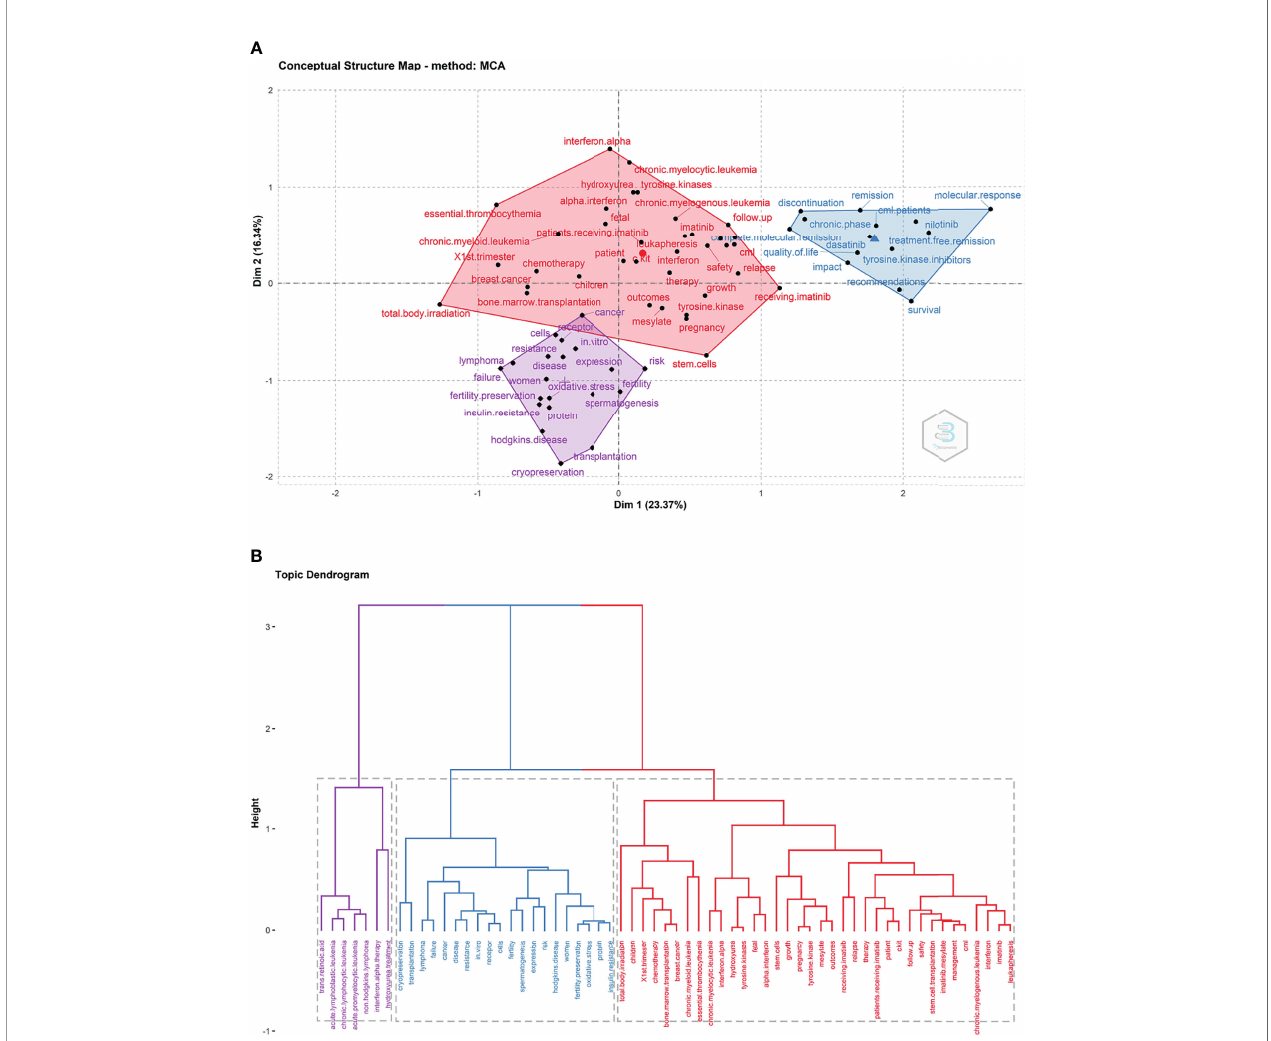
FIGURE 8 | Structural map of chronic myeloid leukemia in pregnancy research fi ning sharing (2001 and 2020). (A) Conceptual structure map of publications. (B) Topic